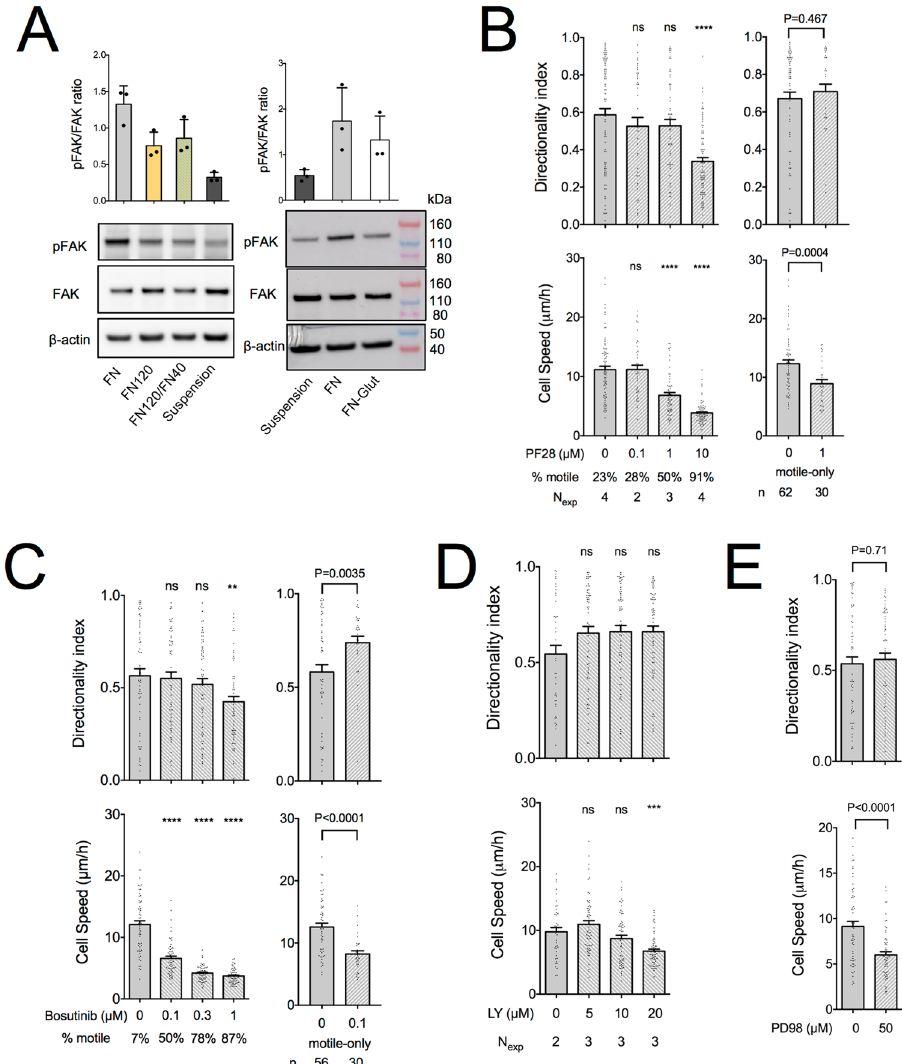
Figure 8. Cell speed and directional persistence in fibroblast migration are differentially regulated. ( A ) Western blot analysis of phosphorylated (Y397) and total FAK from REF lysates, prepared from cells seeded on indicated substrates for 30 minutes. Quantification through densitometry (N exp = 3) revealed higher pFAK Y397 levels on FN compared to FN120, FN120/FN40 and FN-Glut. Mean ± s.d. are presented. ( B ) REF speed and directionality index on FN in presence of the FAK inhibitor PF-573228 (PF28). 1 μ M PF28 significantly reduced cell speed but did not affect directional persistence. At 10 μ M, cells did not translocate, but the nucleus still wiggled within the cell body, giving rise to a low speed and directionality index. The percentage of motile cells (cells exhibiting a maximum displacement of > 50 μ m from the point of origin at any time during the observation period) and the number of independent experiments are indicated on the graph. When motile- only cells were analyzed, a non-significant increase in directionality index was observed for cells treated with 1 μ M PF28 compared to controls (unpaired t-test with Welch’s correction). ( C ) REF speed and directionality index on FN in presence of the c-Src inhibitor Bosutinib revealed similar results to FAK inhibition. At concentrations of 0.1 and 0.3 μ M, Bosutinib significantly reduced cell speed but did not affect directional persistence. The percentage of motile cells is indicated on the graph (N exp = 3; n = 60). Directionality index for motile-only cells was significantly higher for 0.1 μ M Bosutinib compared to controls (unpaired t-test with Welch’s correction). ( D ) REF speed and directionality index on FN in presence of the PI3K inhibitor LY294,002 (LY). PI3K inhibition resulted in a reduction of cell speed at 20 μ M, and a small, non-significant increase in directionality index. ( E ) REF speed and directionality index on FN in presence of the MEK inhibitor PD98059 (PD98). Inhibition of the ERK/MAPK pathway resulted in a significant reduction of cell speed but had no effect on directional persistence (N exp = 3; n = 60). Control conditions (0 μ M) in ( B – E ) correspond to samples with the same amount of DMSO as that used for the highest inhibitor concentration. Values in presence of inhibitors were compared to controls using one-way ANOVA analysis ( B – D ) or unpaired t-tests ( E ). Coating concentrations of FN: 10 μ g/ml. Mean ± s.e.m. are presented. ns: not significant; ** P < 0.01, *** P < 0.001, **** P <